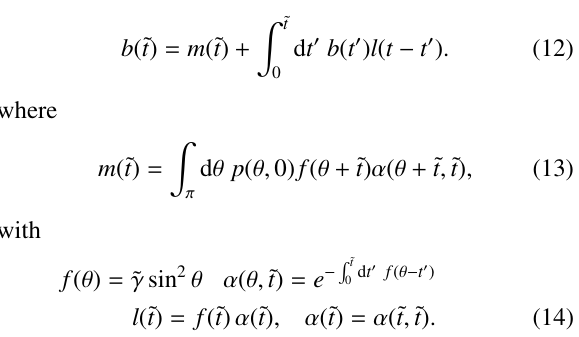
[8] where t stands for ˜ t = ⌦ t /